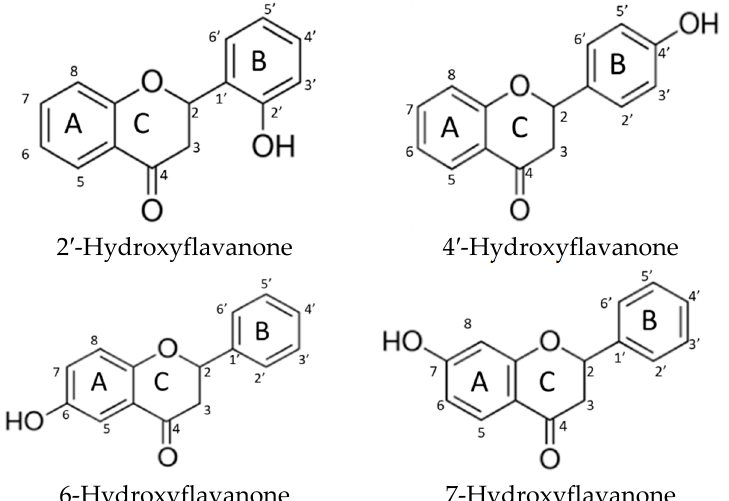
Figure 1. Chemical structure of hydroxyflavanone.